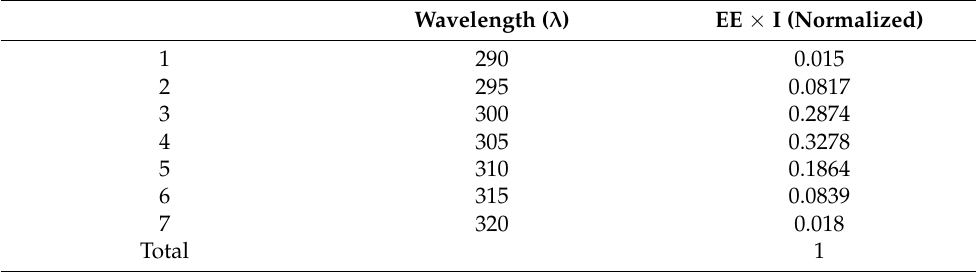
Table 4. Normalized values of erythema effect and solar spectrum intensity